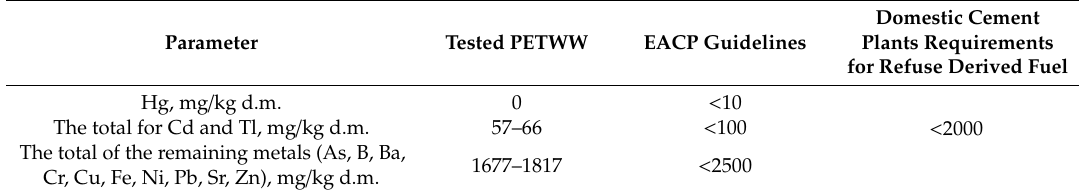
Table 4. The content of heavy metals in PETWW and the limit values required for alternative fuels in cement plants and requirements of the European Association of Cement Producers